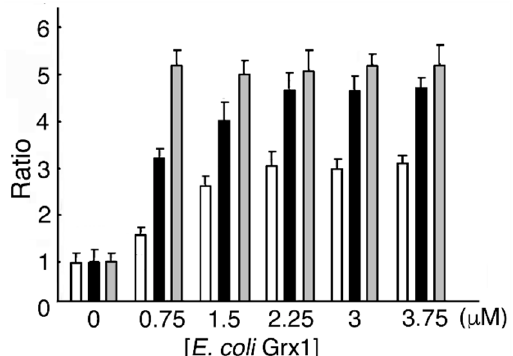
Figure 4. Escherichia coli Grx1 and GSH dose-dependent MST activation. One MST reducing system